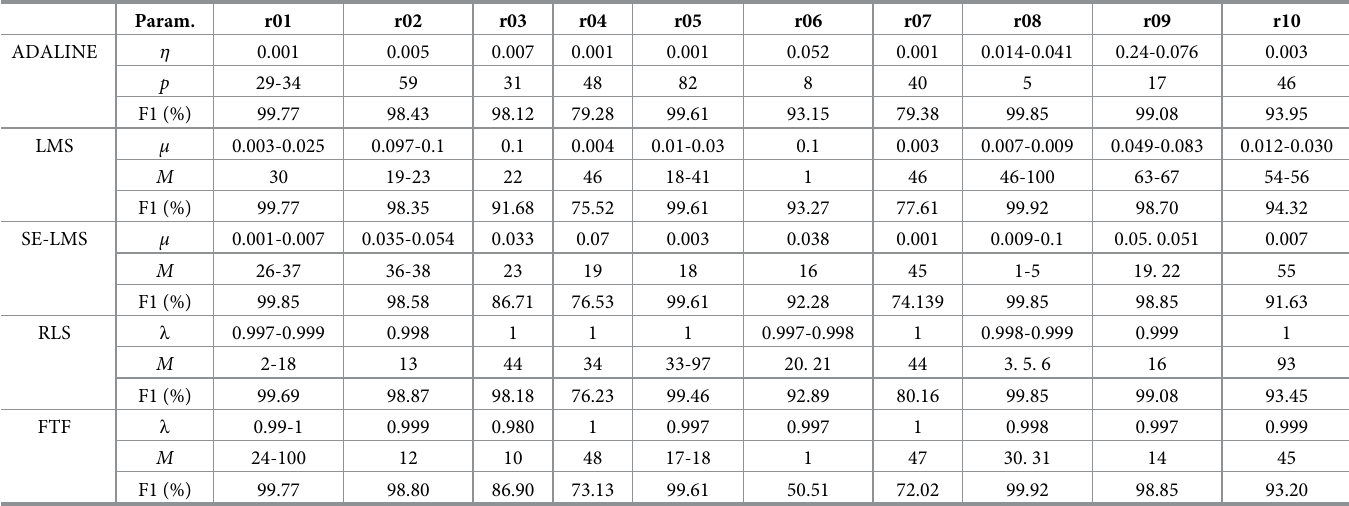
Table 2. Optimal extraction system settings for each recording and each tested method. Param.